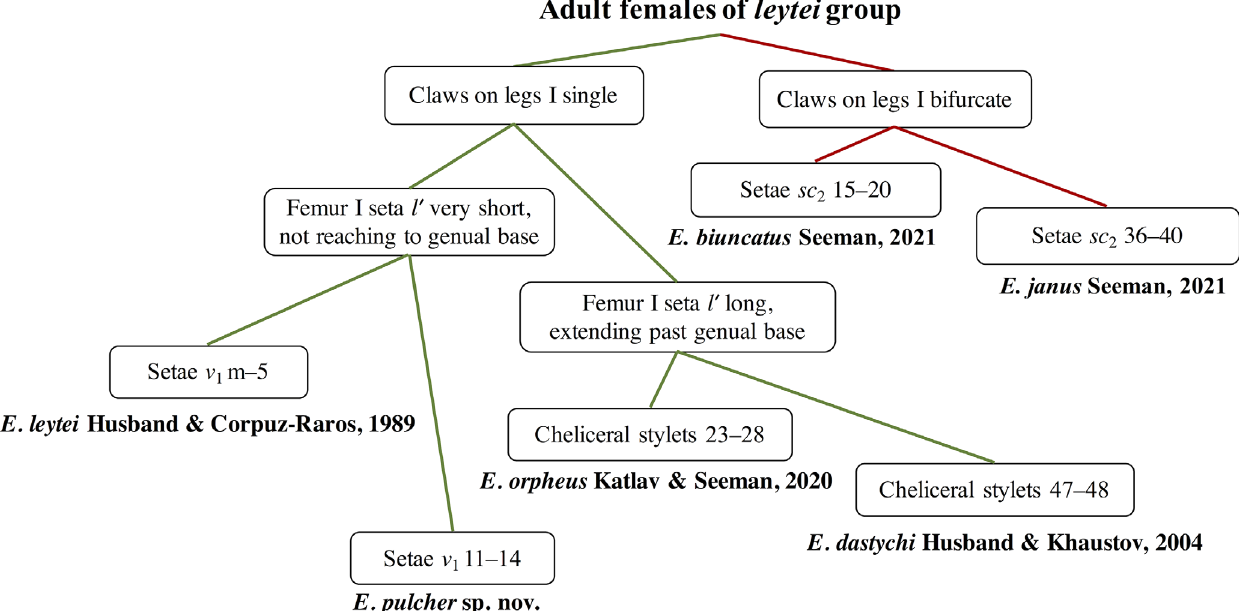
Figure 9. Key to the world species of Eutarsopolipus in the leytei group (based on adult